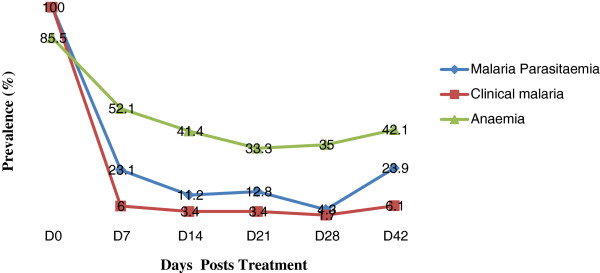
Prevalence of malaria parasitaemia, clinical malaria and anaemia during follow up.